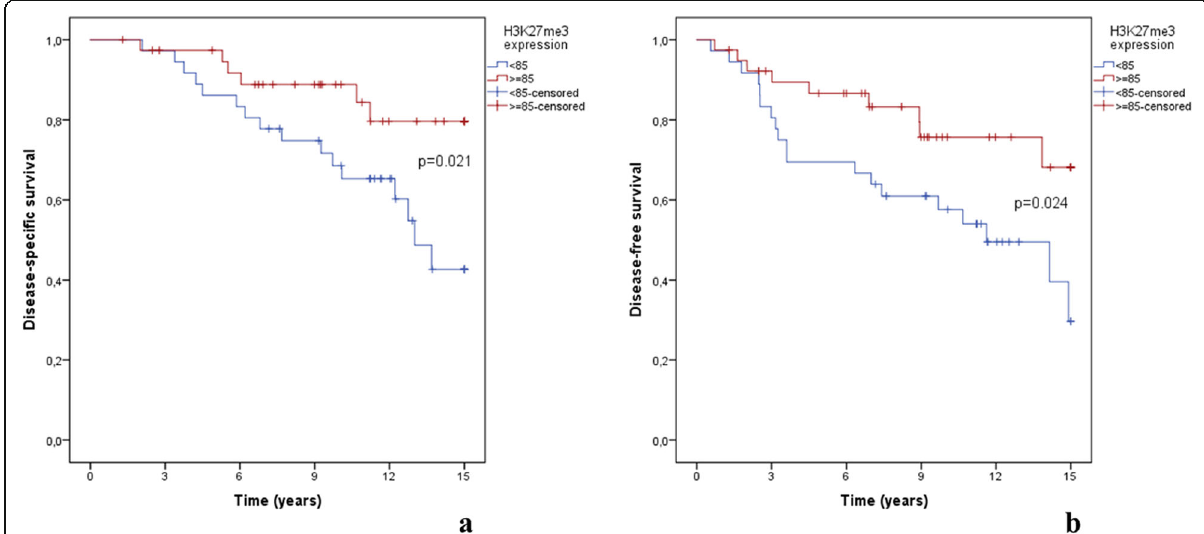
Fig. 3 Kaplan – Meier analysis (censored at 15 years of follow-up) in the below the median age population (age < 61 years old; N = 76) for a disease-specific survival and b disease-free survival, both according to H3K27me3 expression using 85%